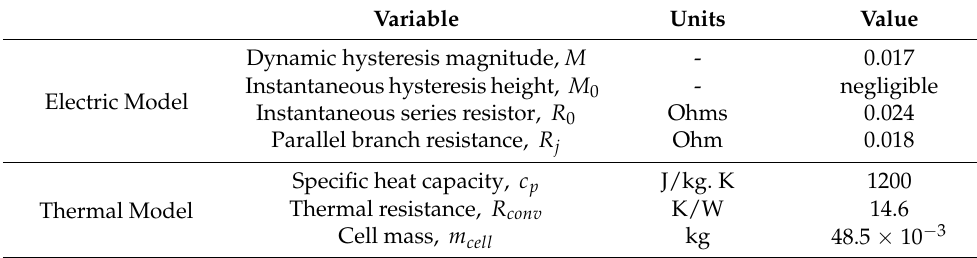
Table 2. List of electrical and thermal model parameters with the estimated values.